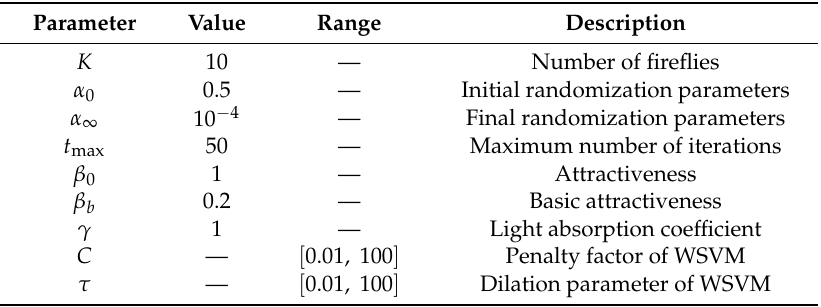
Table 3. The initialization parameters of